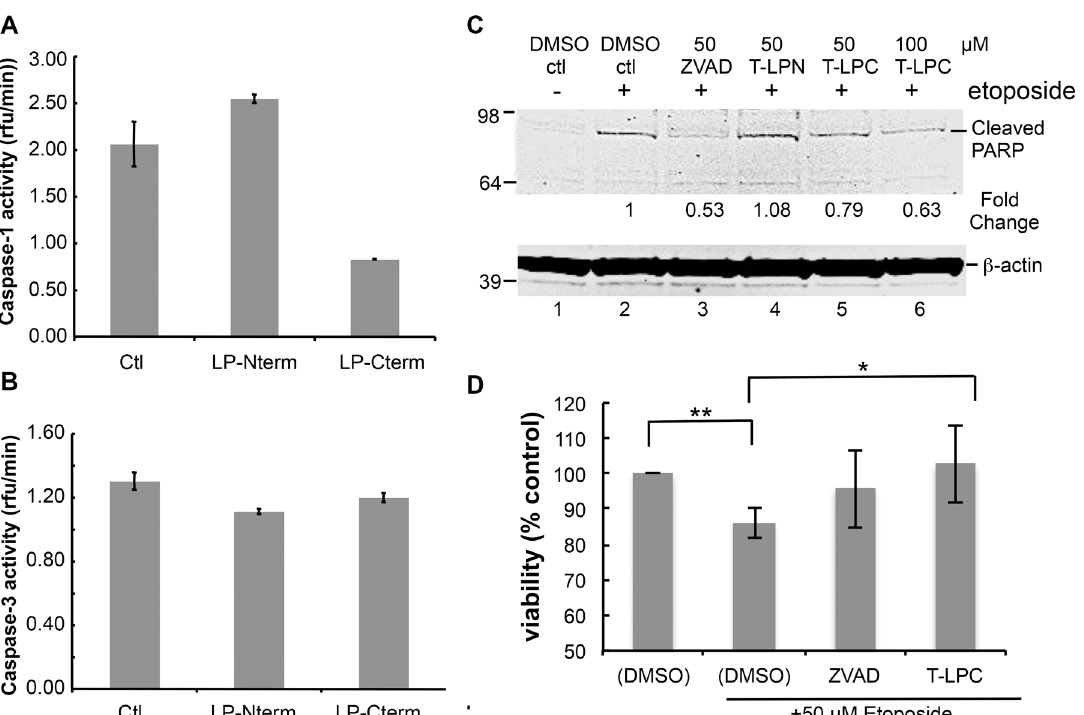
Fig 5. Peptides containing LANA caspase cleavage sites inhibit caspase activity, decrease PARP cleavage and increase cell viability. Caspase activity assays were performed as described in Materials and Methods. Peptides containing the N-terminal caspase cleavage site of LANA (LP-Nterm) or the C-terminal caspase cleavage site of LANA (LP-Cterm) were dissolved in PBS and tested as potential caspase inhibitors at a concentration equal to the commercial caspase-1 substrate (Ac-YEVD-pNa, 200 μ M, Sigma) or caspase-3 substrate (Ac-DEVD-pNa, 200 μ M, Sigma). PBS was used as the negative control. (A) Effect of LP-Nterm and LP-Cterm on caspase-1 activity. (B) Effect of LP-Nterm and LP-Cterm on caspase-3 activity. In both A and B, the linear caspase activity rate (rfu/min) is plotted with the assay run in triplicate in two separate experiments with one representative experiment shown. Note: The increase in activity of caspase-1 by the LP-Nterm may be due to the presence of a cysteine in this peptide which could protect loss of activity of the enzyme due to oxidation over time. (C) HEP3B cells were pre-treated with DMSO, ZVAD, Tat-LP-Nterm (T-LPN) or Tat-LP-Cterm (T-LPC) peptide for two hrs and then exposed to DMSO alone (control) or etoposide for 16 hrs at 50 μ m to induce apoptosis and PARP cleavage. Cell lysates were analyzed by western blot for cleaved PARP and β -actin (loading control). The percent inhibition of PARP cleavage as determined using the LiCor system is indicated below the blot. The immunoblot shown is a representative of 3 different experiments with Tat-LP-Nterm and Tat-LP-Cterm at 50 μ M (Tat-LP-Cterm at 100 μ M done once). (D) Cell viability following pretreatment with DMSO, ZVAD or T-LPC followed by DMSO or etoposide treatment. Cells were pretreated with DMSO (control), Tat-LP-Cterm or ZVAD (50 μ M) for two hrs followed by etoposide treatment at 50 μ M. To assess cell viability total cellular protein obtained from the adherent cells following 3 PBS washes was determined by BCA assay. The results shown are the average of 4 independent experiments. ** P < 0.01, * P < 0.05, for two tailed Student ’ s